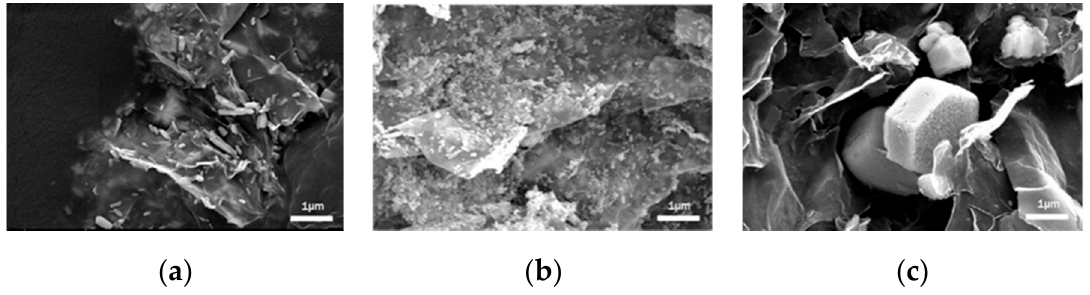
Figure 1. FESEM micrographs of ( a ) ZnO/GO-5wt%, ( b ) ZnO/GO-10wt%, ( c ) ZnO/GO-15wt%.